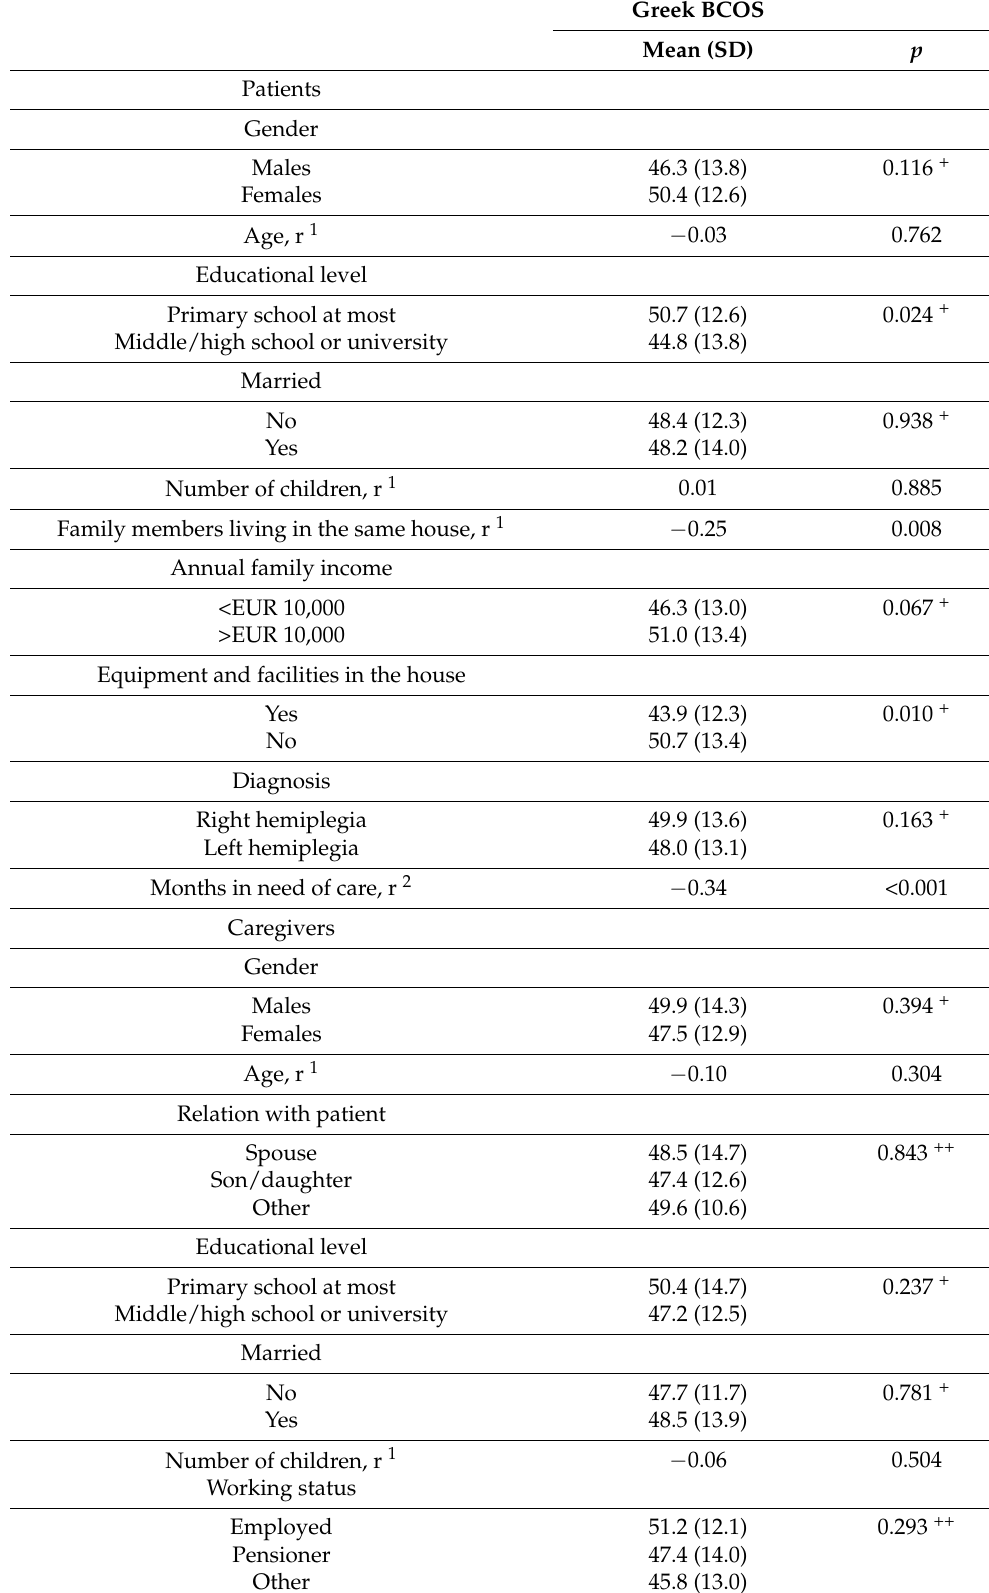
Table 3. Univariate analysis for Greek BCOS with patients’ and caregivers’